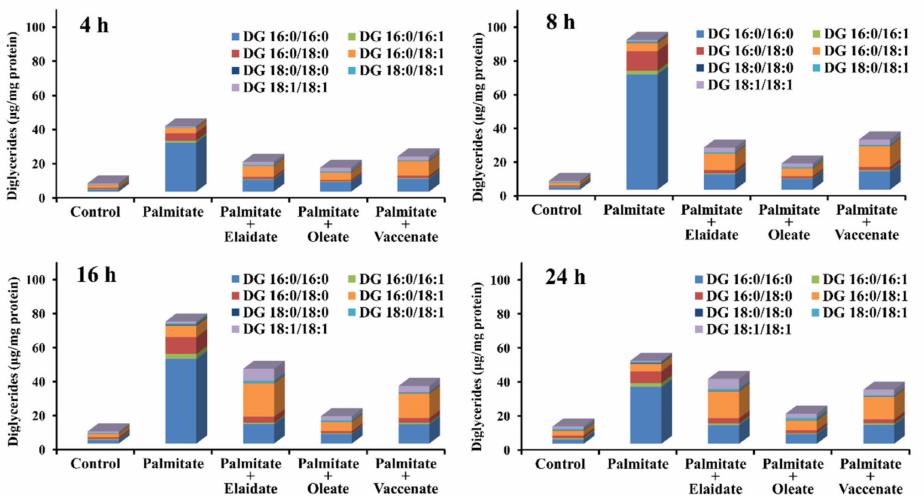
Figure 5. Diglyceride accumulation. Cells were treated with BSA (control cells) or BSA-conjugated palmitate alone, or with palmitate and one of the unsaturated fatty acids, elaidate, oleate or vaccenate at 250 µ M individual concentration for 8 h at 70%–80% confluence. The amount of seven major diglyceride species was measured by LC-MS / MS in the washed cell samples prepared after 4, 8, 16 or 24 h treatments. The detected diglycerides contained the indicated combinations of palmitate (16:0), stearate (18:0), and a monounsaturated fatty acid of 16 (16:1) or 18 carbons (18:1). Data were normalized to the protein content of the samples, and are shown as mean values of three independent experiments with two